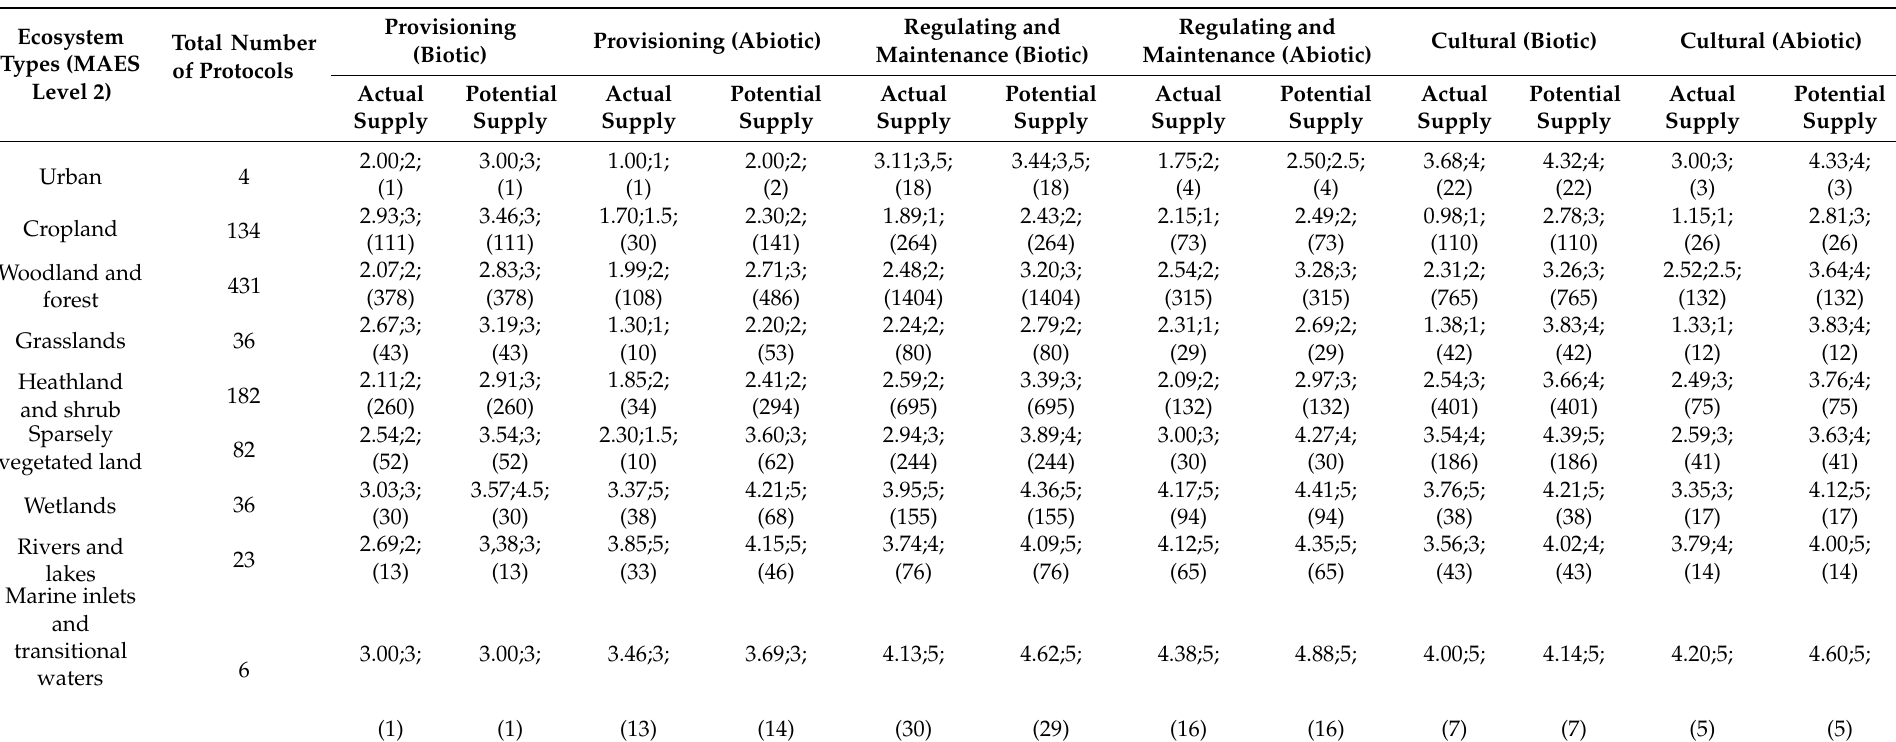
Table 6. Major ecosystem services categories actual and potential supply per MAES level 2 ecosystem types. Each record depicts: mean rating; median of rates; (reference number of protocols).